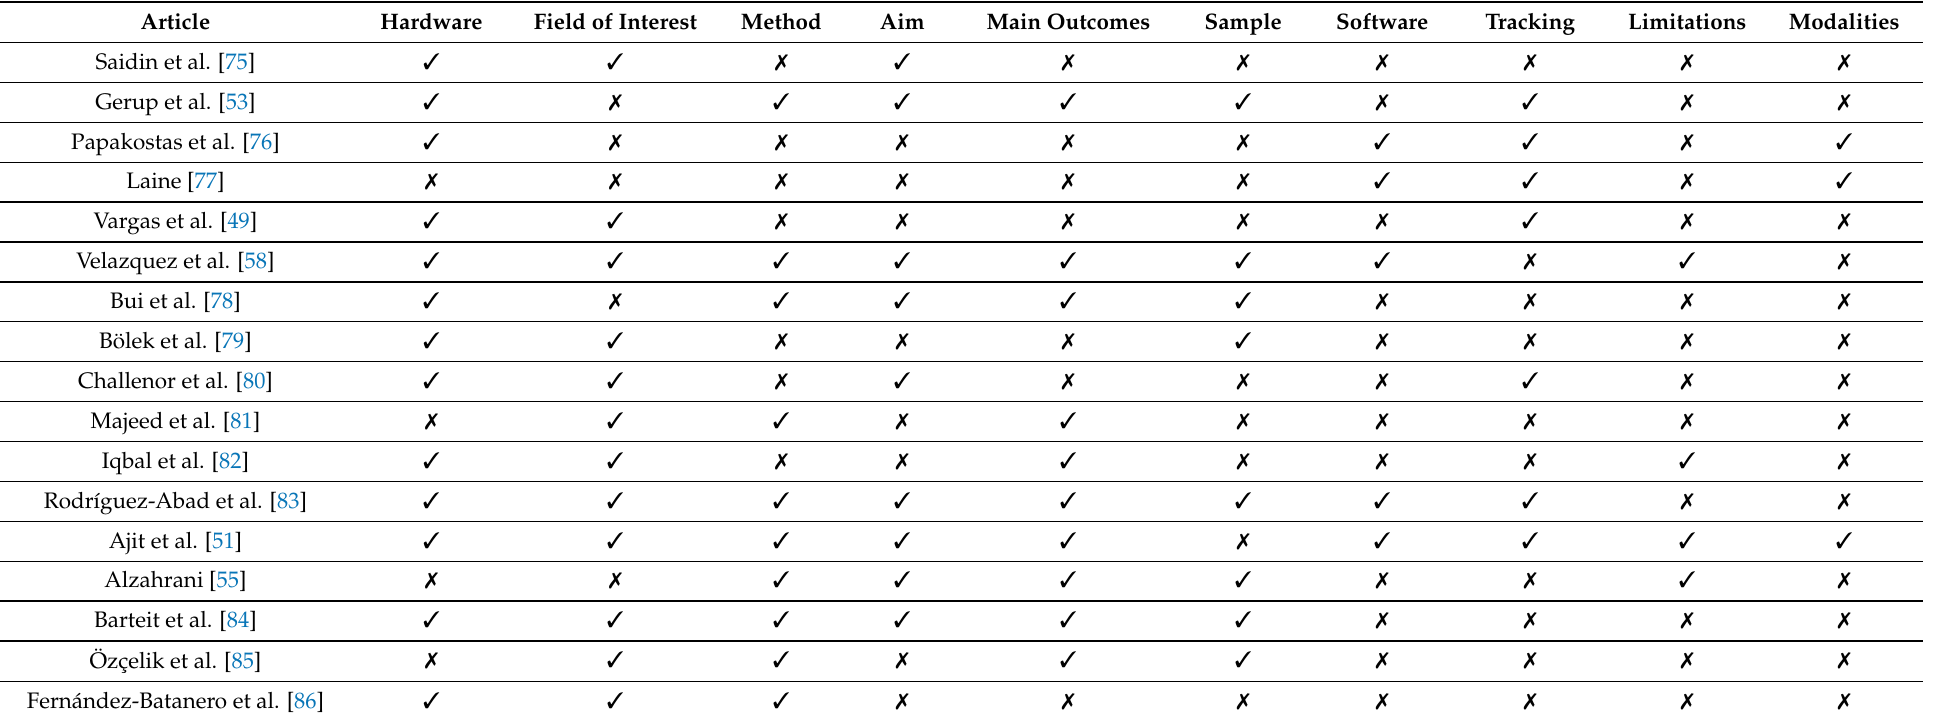
Table 2. Criteria for education-oriented AR review